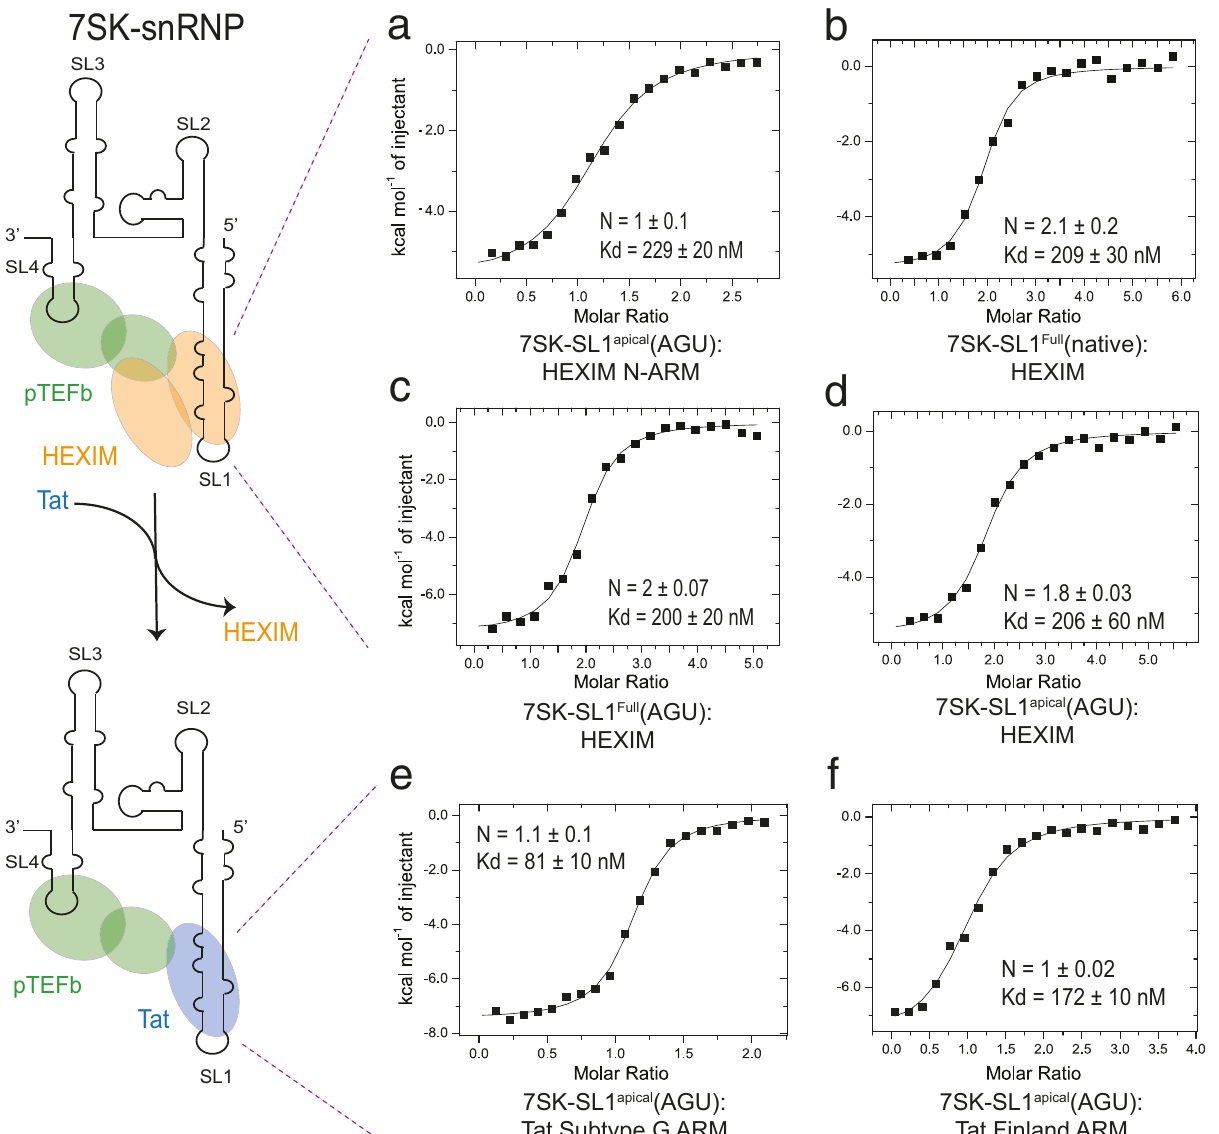
Fig. 1 Characterization of HEXIM and Tat binding to 7SK. (Left) Cartoon representation of the HEXIM dimer and pTEFb heterodimer binding to the 7SK snRNP (top left). Upon introduction of Tat, HEXIM is displaced from the snRNP (bottom left). Not depicted are MEPCE and LARP7. Representative ITC data for HEXIM N-ARM binding to 7SK-SL1 apical-AGU (G 26 -C 85 ) ( a ) compared to full-length HEXIM1 bound to 7SK-SL1 Full (G 1 -C 108 ) with a wild-type loop ( b ) or an AGU triloop ( c ) and full-length HEXIM1 binding to 7SK-SL1 apical-AGU ( d ) all show similar binding af fi nities, indicating that the loop does not play a signi fi cant role in dimeric HEXIM binding and that the HEXIM N-ARM :7SK-SL1 apical-AGU complex represents the minimal binding interaction. Representative ITC traces of the Tat G ( e ) and Tat Fin ( f ) ARMs into 7SK-SL1 apical-AGU show an ~2.8 and 1.3-fold increased binding af fi nity compared to HEXIM N-ARM , respectively. All reported values are for n = 3 af fi nity over HEXIM N-ARM (Supplementary Table 1). On the other hand, Tat Finland ’ s ARM (KR 52 KHRRR), despite having an additional N-terminal arginine compared to the HEXIM N-ARM (R52 and K151, respectively), does not have a statistically signi fi cant increase in binding af fi nity over HEXIM N-ARM ( K d of 172 ± 10 nM, N = 1 ± 0.02; Fig. 1f). Overall, these results highlight the need for understanding the HEXIM-bound 7SK; while the increased Tat G af fi nity would allow for HEXIM displacement, it is unclear how Tat Fin can achieve the same biological output.